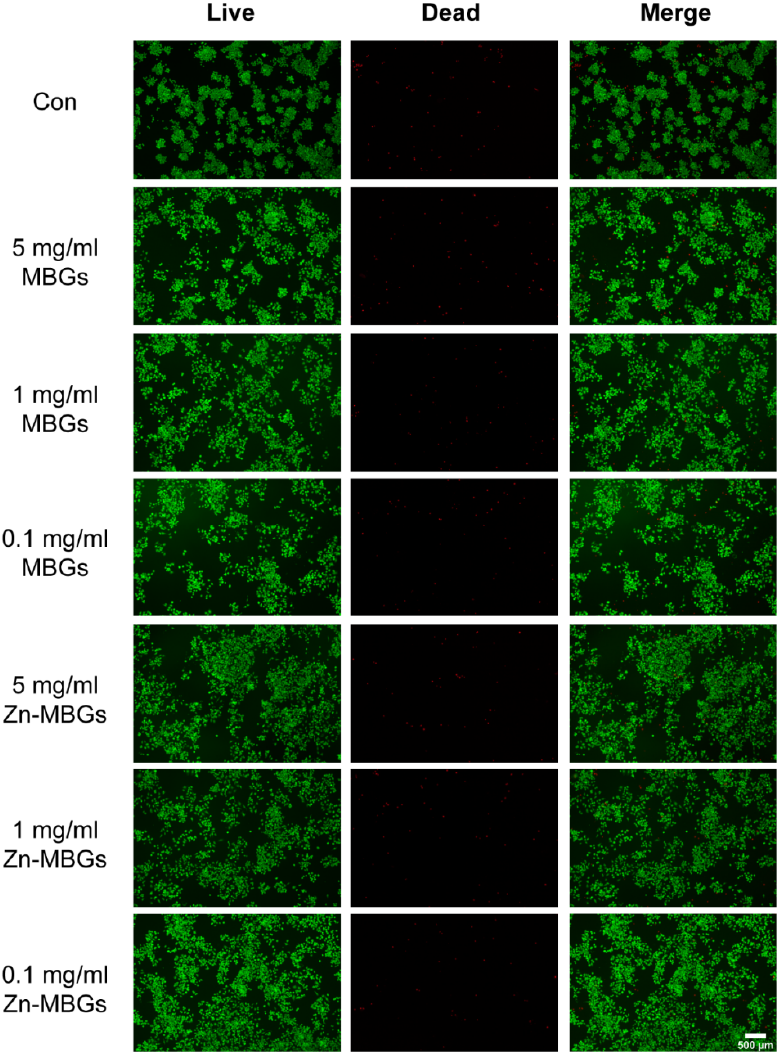
Figure 5. Live/dead staining of RAW264.7 cells incubated with MBGs and Zn-MBGs at different concentrations for 24 h. Green staining represents living cells, while red staining represents dead cells.